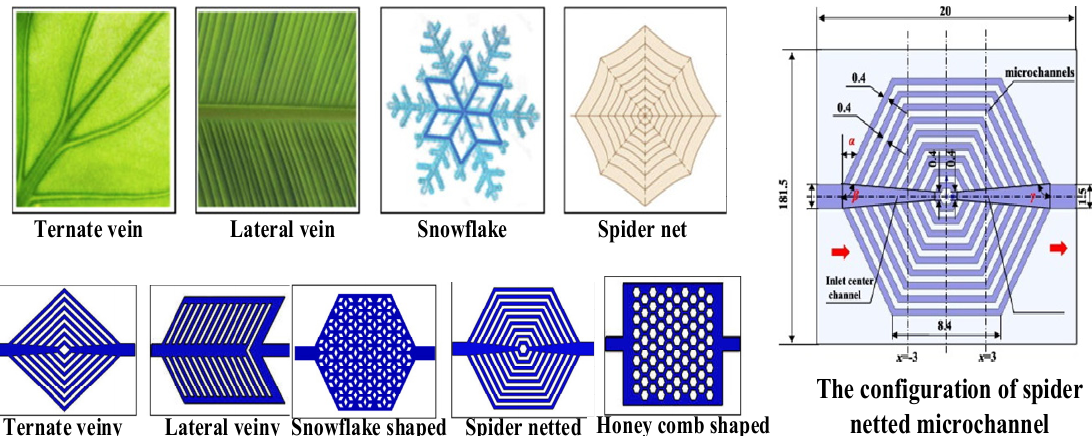
Figure 15. Schematic diagram of microchannel topology design and optimization, (adapted from Ref. [114]).